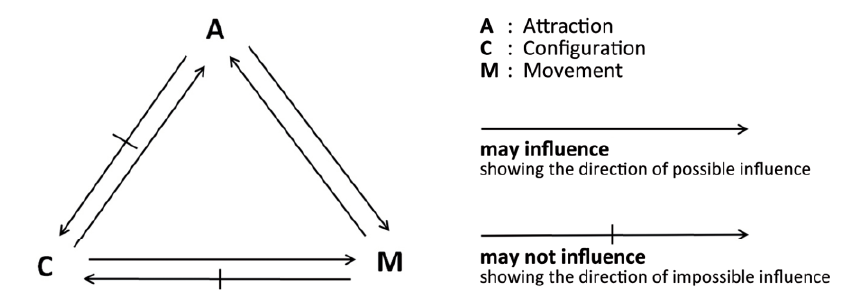
Figure 3 Attraction, configuration, and movement (Hillier, et. all.,